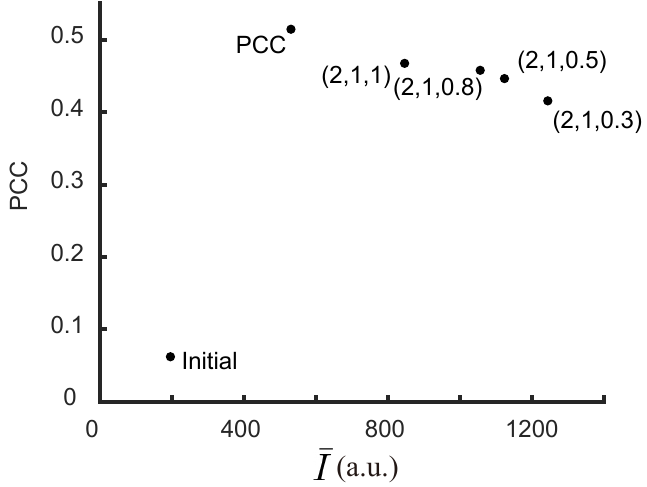
Figure 14. Pearson correlation coefficients (PCCs) and average intensities ¯ I for different sets of ranking coefficients ( a , b , c ) after the 600th generation. The ranking coefficients are labeled near the points. The initial point is also shown in the bottom left